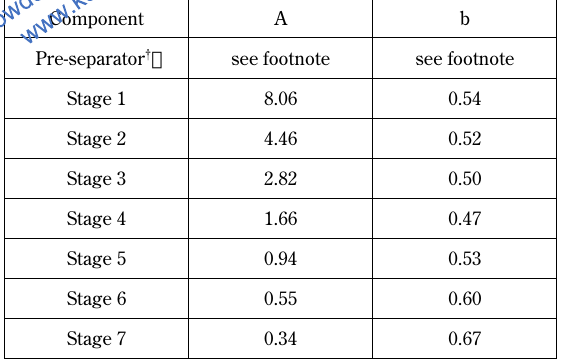
Table 10 Values of constants ‘A’ and ‘b’ (Equation 10) for the NGI